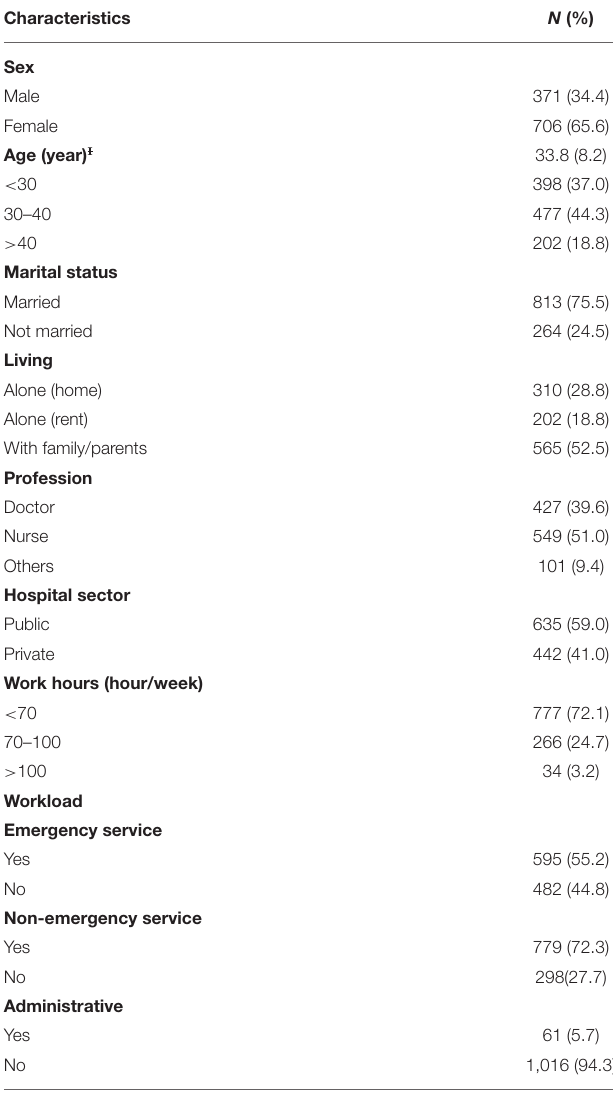
TABLE 1 | Sociodemographic and occupational characteristics of the study sample ( N = 1,077).